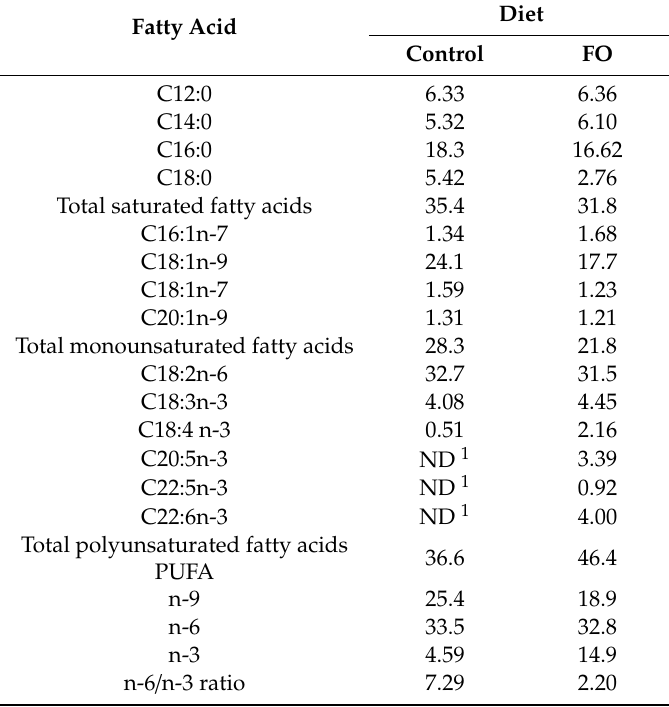
Table 1. Fatty acid composition (g / 100 g of total fatty acid methyl esters) of diets with either lard (control) or with fish oil (FO) as the fat source. Diet Fatty Acid Control FO C12:0 6.33 6.36 C14:0 5.32 6.10 C16:0 18.3 16.62 C18:0 5.42 2.76 Total saturated fatty acids 35.4 31.8